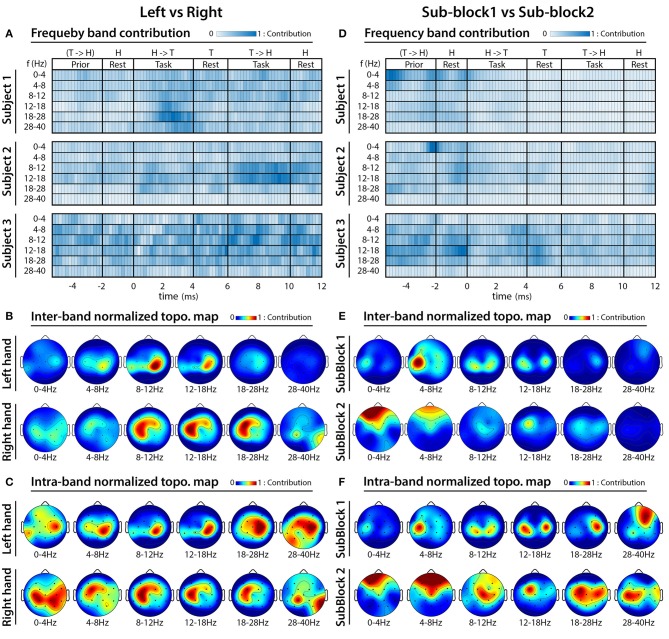
FBCSP: results of frequency analysis and topographical maps using multi-session dataset. (A–C) Indicate which frequency bands and cortical areas provided the highest contribution for separating imagined movements performed with left vs. right hands at that time for which the classification accuracy was maximal. (D–F) Indicate which frequency bands and cortical areas provided the highest contribution for separating imagined movements performed in sub-block 1 vs. sub-block 2 at that that time for which the classification accuracy was maximal. The subject-specific frequency band contribution maps (A,D) were calculated at peak accuracy using MI weights of the trained 2-class classifiers, which were applied to the multi-class classifier module. The cross-subject topographical maps (B,C,E,F) were calculated using average of the MI weighted CSP filters, which were used from subject-specifically trained 2-class classifiers applied to the multi-class classifier module. For calculating an averaged pattern for the cross-subject topographical plots, the MI weighted CSP filters subject-specifically were selected at peak accuracy of the corresponding subjects.